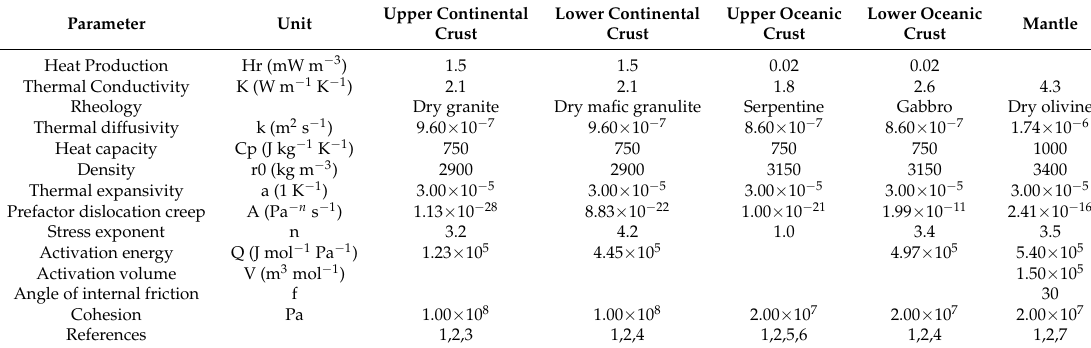
Table 4. Material and rheological parameters used in the simulation. References: (1) Afonso and Ranalli [147]; (2) Schoen [148]; (3) Ranalli [149]; (4) Wilks and Carter [150]; (5) Hilairet et al. [151]; (6) Petersen and Schiffer [152]; (7) Karato and Wu